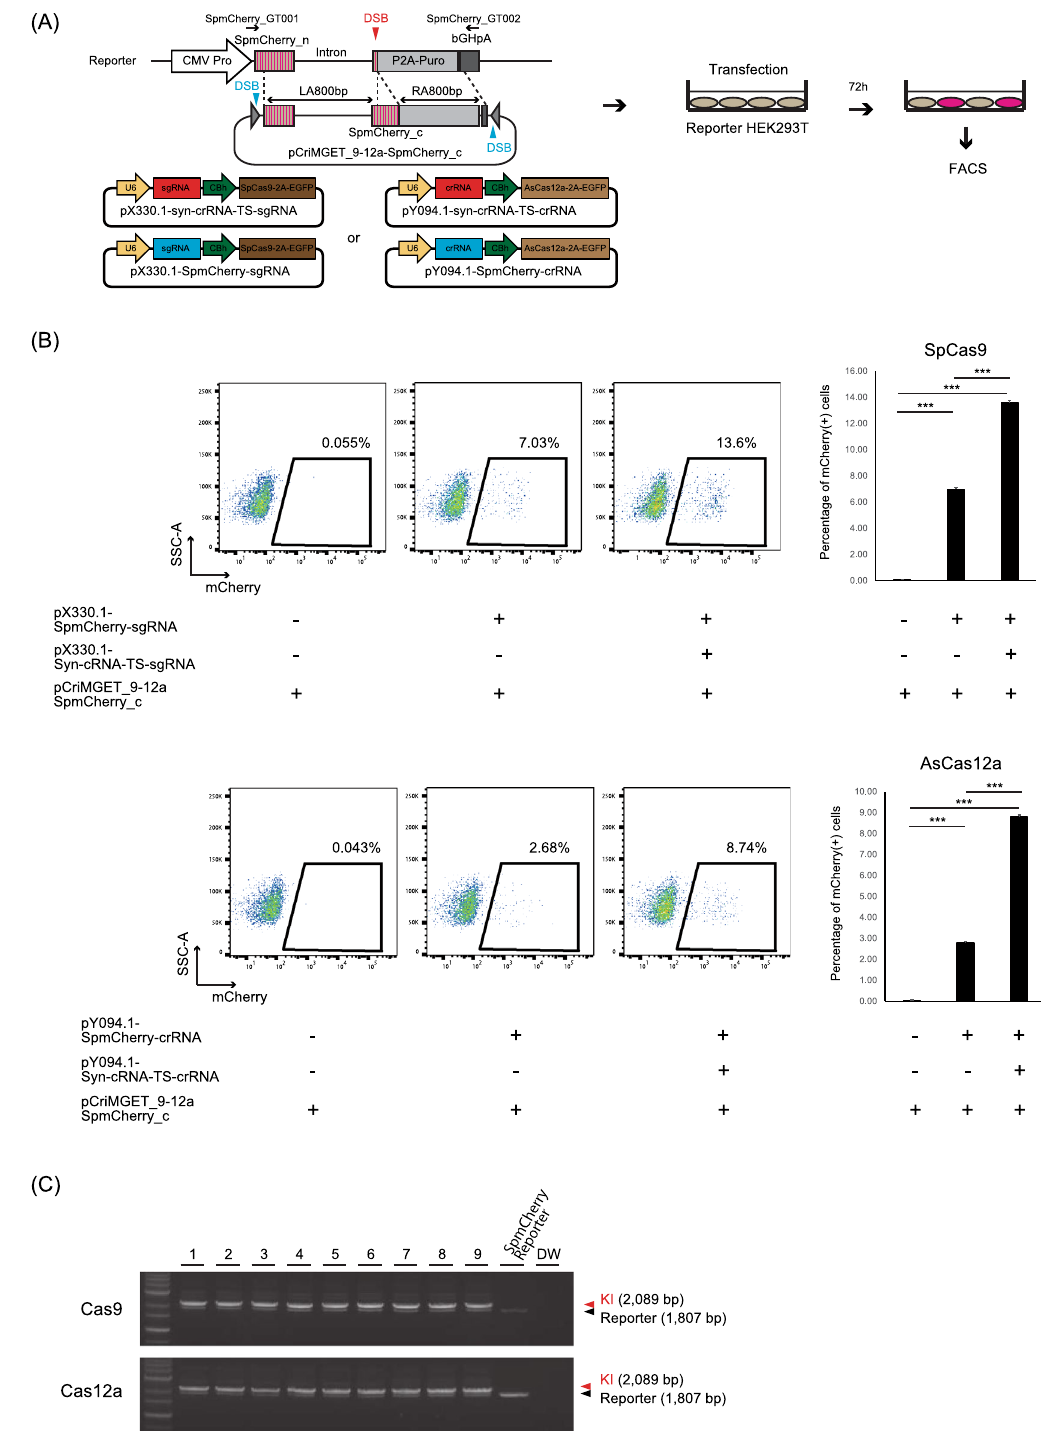
Figure 2. Precise in-frame knock-in of exogenous DNA by the pCriMGET_9-12a/CRISPR-Cas9 and pCriMGET_9-12a/CRISPR-Cas12a systems. ( A ) Development of the Split-mCherry reconstitution system for analyzing the in-frame knock-in efficiency of the pCriMGET_9-12a system. ( B ) Fluorescence-activated cell sorting (FACS) analysis of mCherry expression in the Split-mCherry reporter HEK293T cells transfected with the indicated plasmids (upper, pCriMGET_9-12a/CRISPR-Cas9 system; lower, pCriMGET_9-12a/CRISPR-Cas12a system). The mCherry + population in EGFP + cells is gated. The graphs on the right show average percentages of mCherry + cells among EGFP + cells in each sample. Mean ± s.d. from three experiments. *** P < 0.001, by Tukey’s multiple comparison test. ( C ) Genotyping PCRs for Split-mCherry reconstituted single-cell clones (upper, pCriMGET_9- 12a/CRISPR-Cas9 system; lower, pCriMGET_9-12a/CRISPR-Cas12a system). PCR was performed by using SpmCherry_GT001 and _GT002 primer pairs, which are annealed outside of the homology arms (see ( A )). Knock-in (KI) (2089 bp) and reporter (1807 bp) bands are indicated by red and black arrowheads,